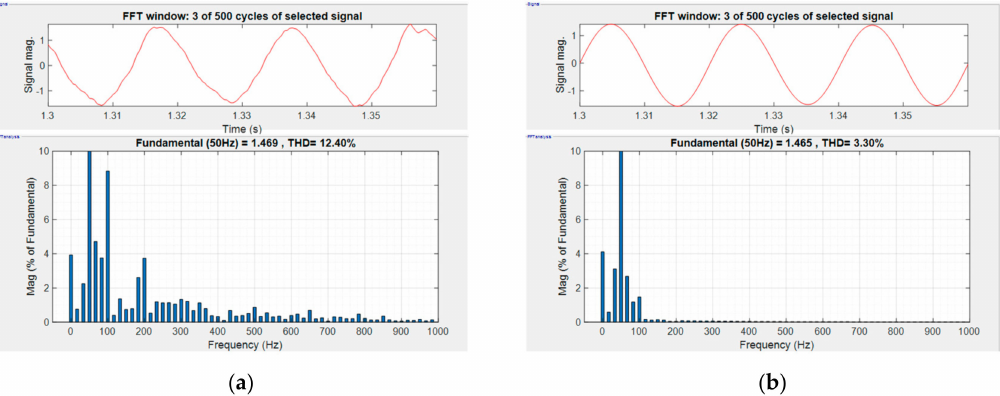
Figure 20. The FFT analysis of the phase-a stator current with ( a ) 6 − sectors and ( b ) 12 − sectors DTC control